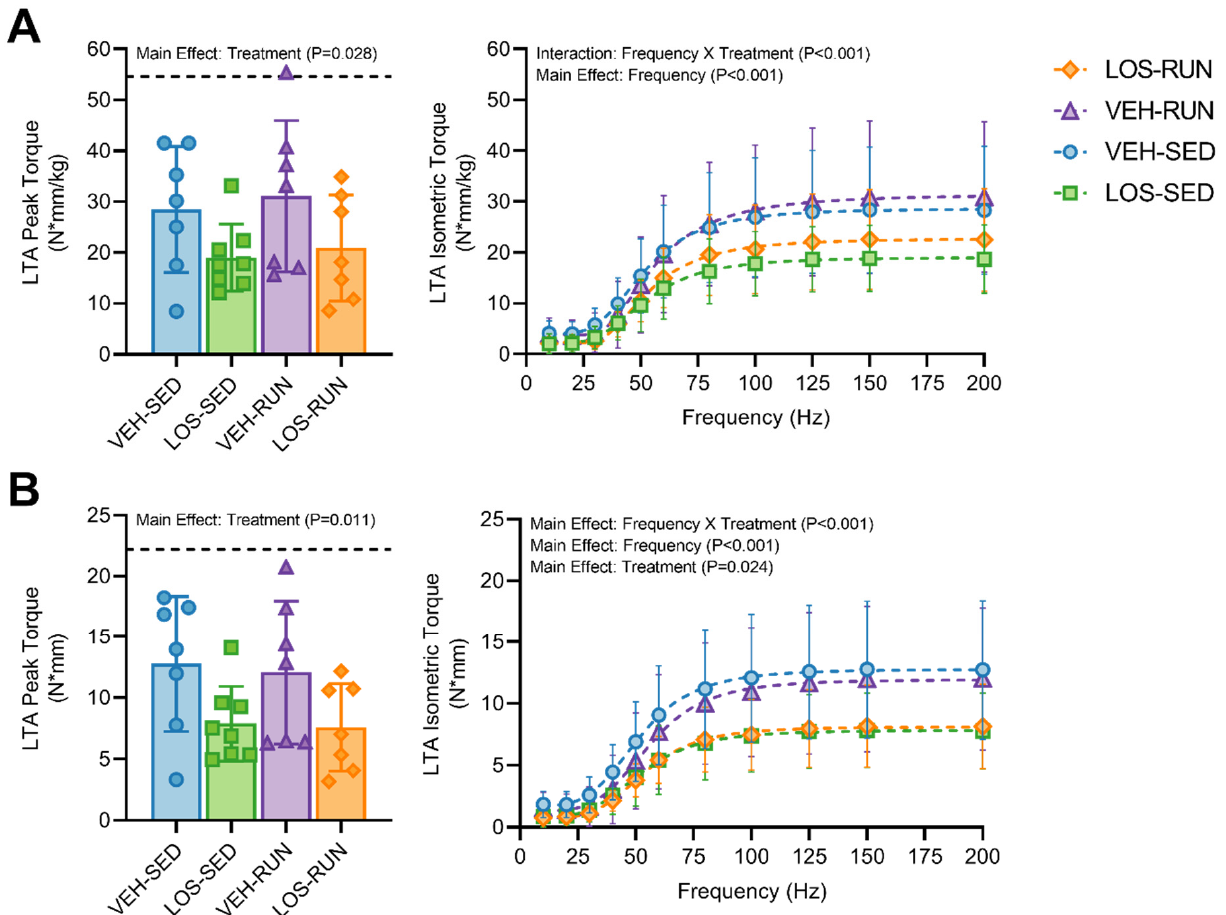
Figure 3. In vivo neuromuscular functional assessment. Evaluation of neuromuscular functional capacity in VML injured limbs was performed at 56 DPI. Peak torque and isometric torque as a function of frequency was evaluated and either normalized to body weight ( A ) or presented non- normalized ( B ). The black-dashed line denotes the average peak torque of the pooled contralateral uninjured limbs. Data are presented as mean ± SD; n = 7–8 rats per group. For LTA peak torque, differences were considered significant when p < 0.05 by a two-way ANOVA followed by the Holm– Sidak post hoc test. For the isometric torque as a function of frequency, differences were considered significant when p < 0.05 by a three-way ANOVA followed by the Holm–Sidak post hoc